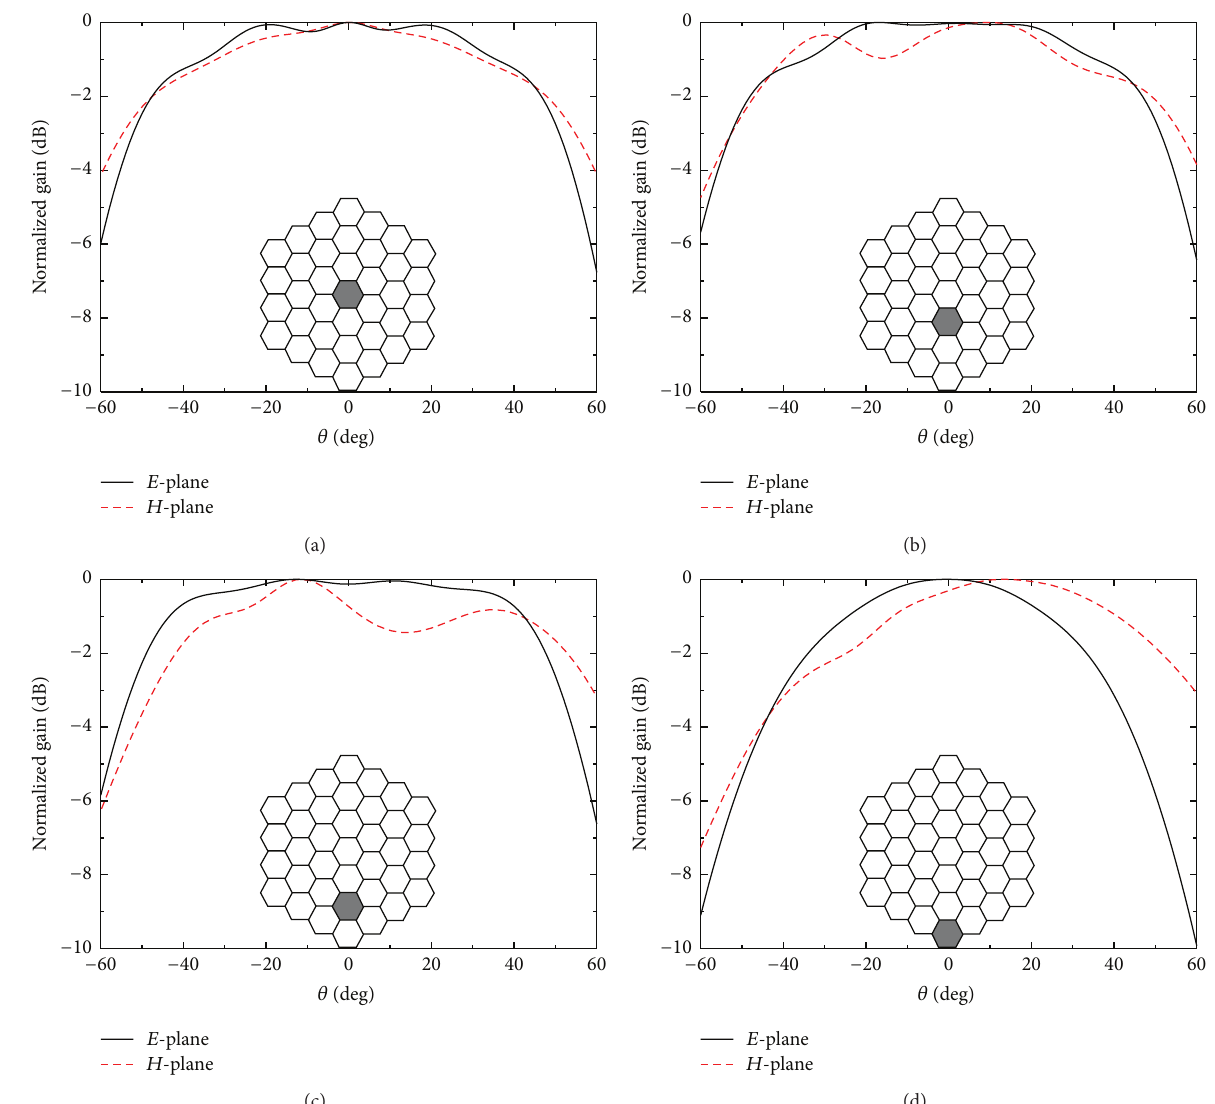
Figure 14: Normalized radiation patterns of one element in different positions of the array with linear polarization. (a) Central position 1. (b) Position 2. (c) Position 3. (d) Position 4.